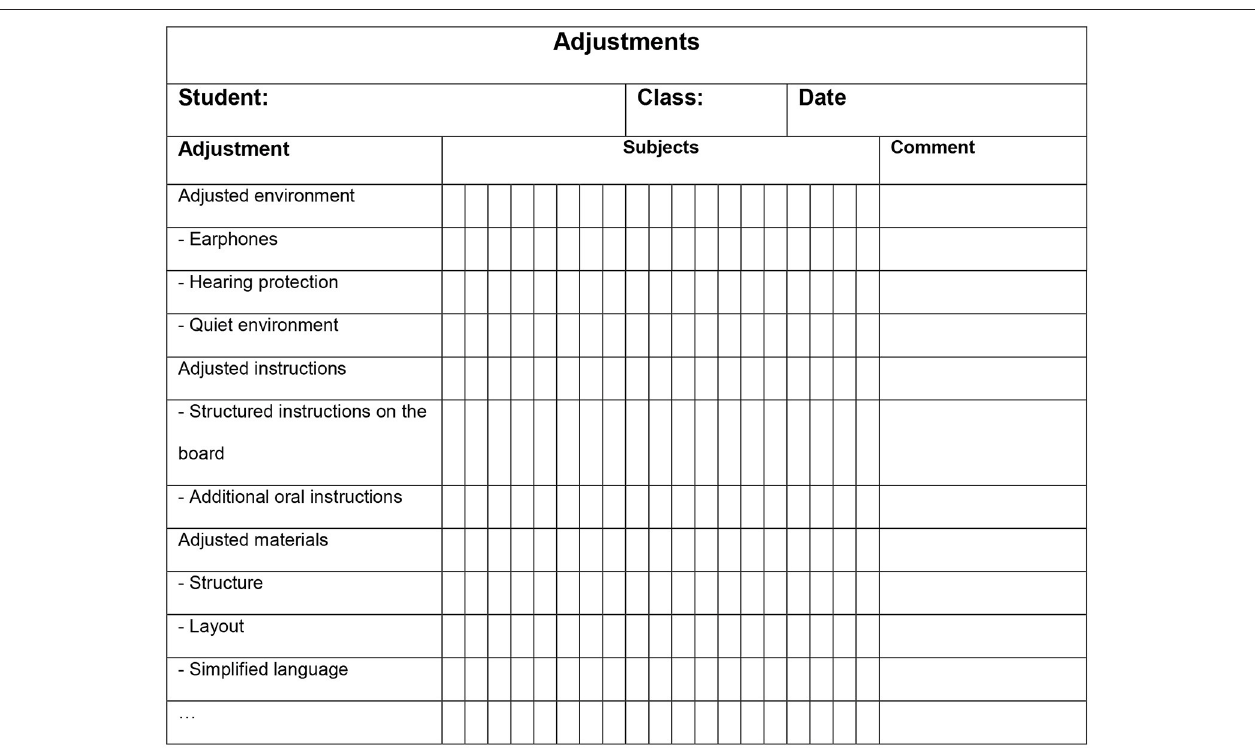
FIGURE 2 | Excerpt from list with suggested adjustments. About one third of the list is shown in the figure. This particular excerpt is from School A, but several schools in the sample had similar